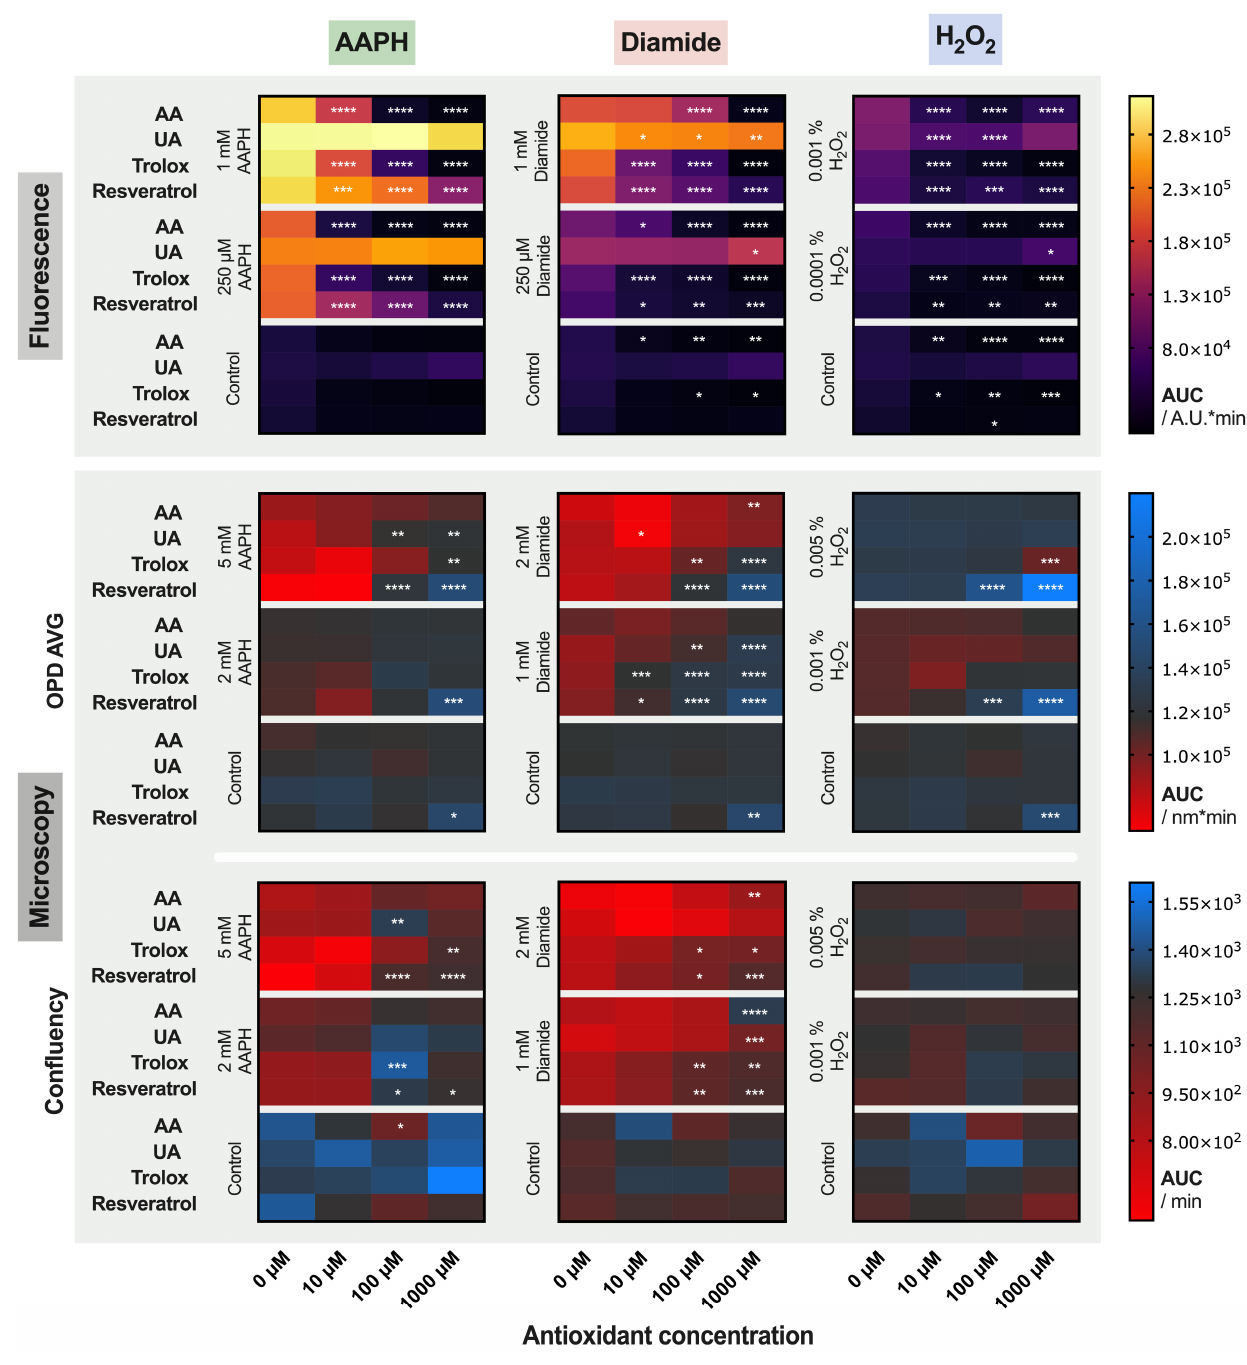
Figure 3. Summary Panel of the Effects on Red Blood Cells (RBCs) of 0, 10, 100 and 1000 µ M Ascorbic Acid (AA), Uric Acid (UA), Trolox and Resveratrol against AAPH, Diamide and H 2 O 2 at Different Concentrations. Top: effect on ROS by fluorescence emission; and bottom: effect on RBC morphology (i.e., average of the optical path difference distribution [OPD AVG] parameter and normalized confluency). Each cell on the heat map represents the mean area under the curve (AUC) for three RBC concentrates (RCCs) under a particular treatment. Two-way ANOVA was performed to compare the effect of the 0 µ M versus 10, 100 or 1000 µ M antioxidant conditions; * p -value < 0.05, ** p -value < 0.01, *** p -value < 0.001, and **** p -value <